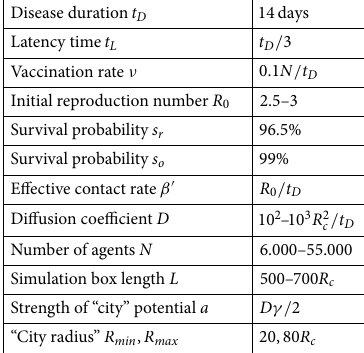
Table 1. Typical simulation parameters.